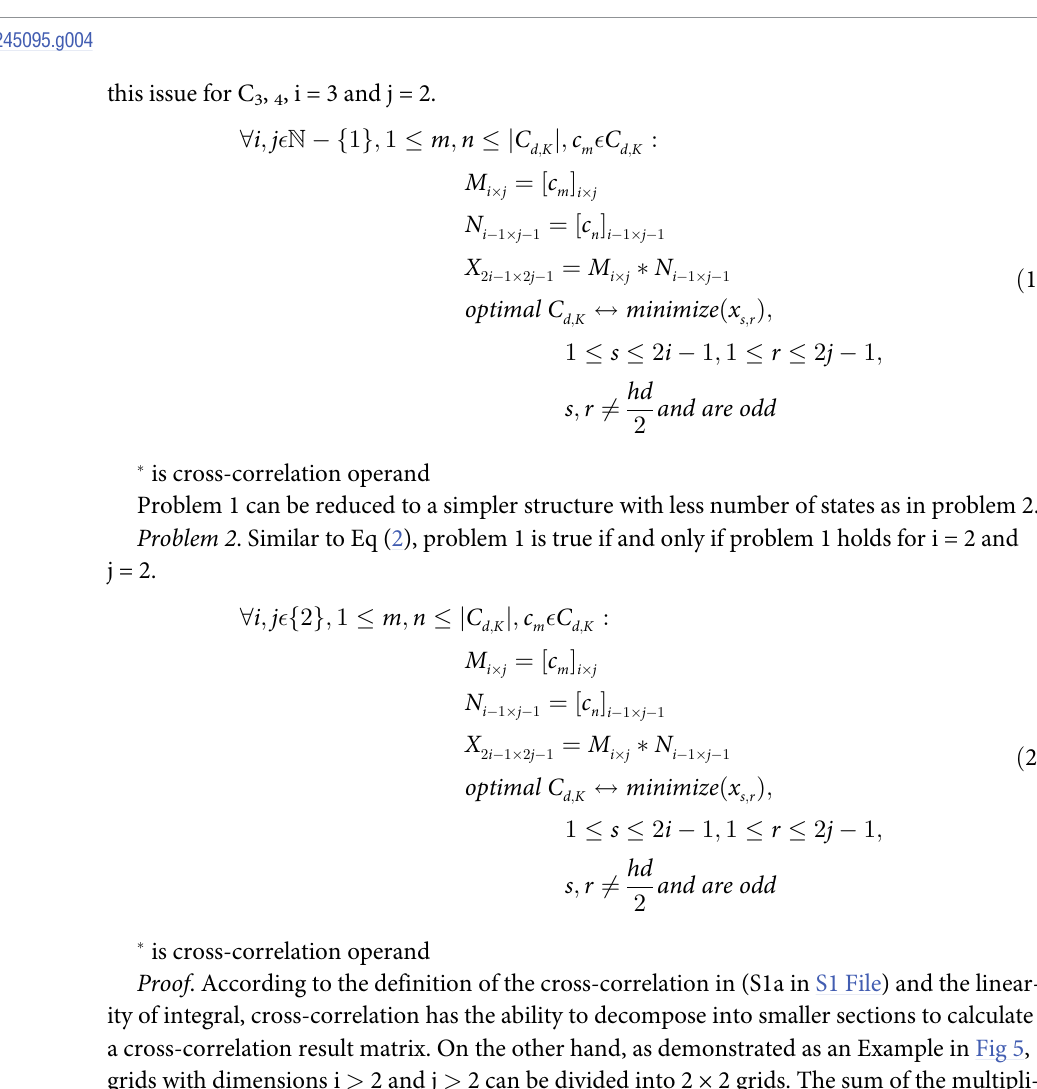
Fig 4. a) Example of coding patterns, b) 16 sample states of all possible 1024 states of problem 1 for C 3, 4 , assuming i = 2 and j = 2, where C 3, 4 is a coding set containing 4 characters that each of them is a 3 × 3 matrix, i and are width and height, respectively, of a grid of codes that contains all combination of C 3, 4 . So, multiplying 4 4 possible states, required for creating this grid, by 4 states for each code leads to 4 5 or 1024 states. Exact matched pattern of single codes and multiple codes overlaps are shown with a green stroke